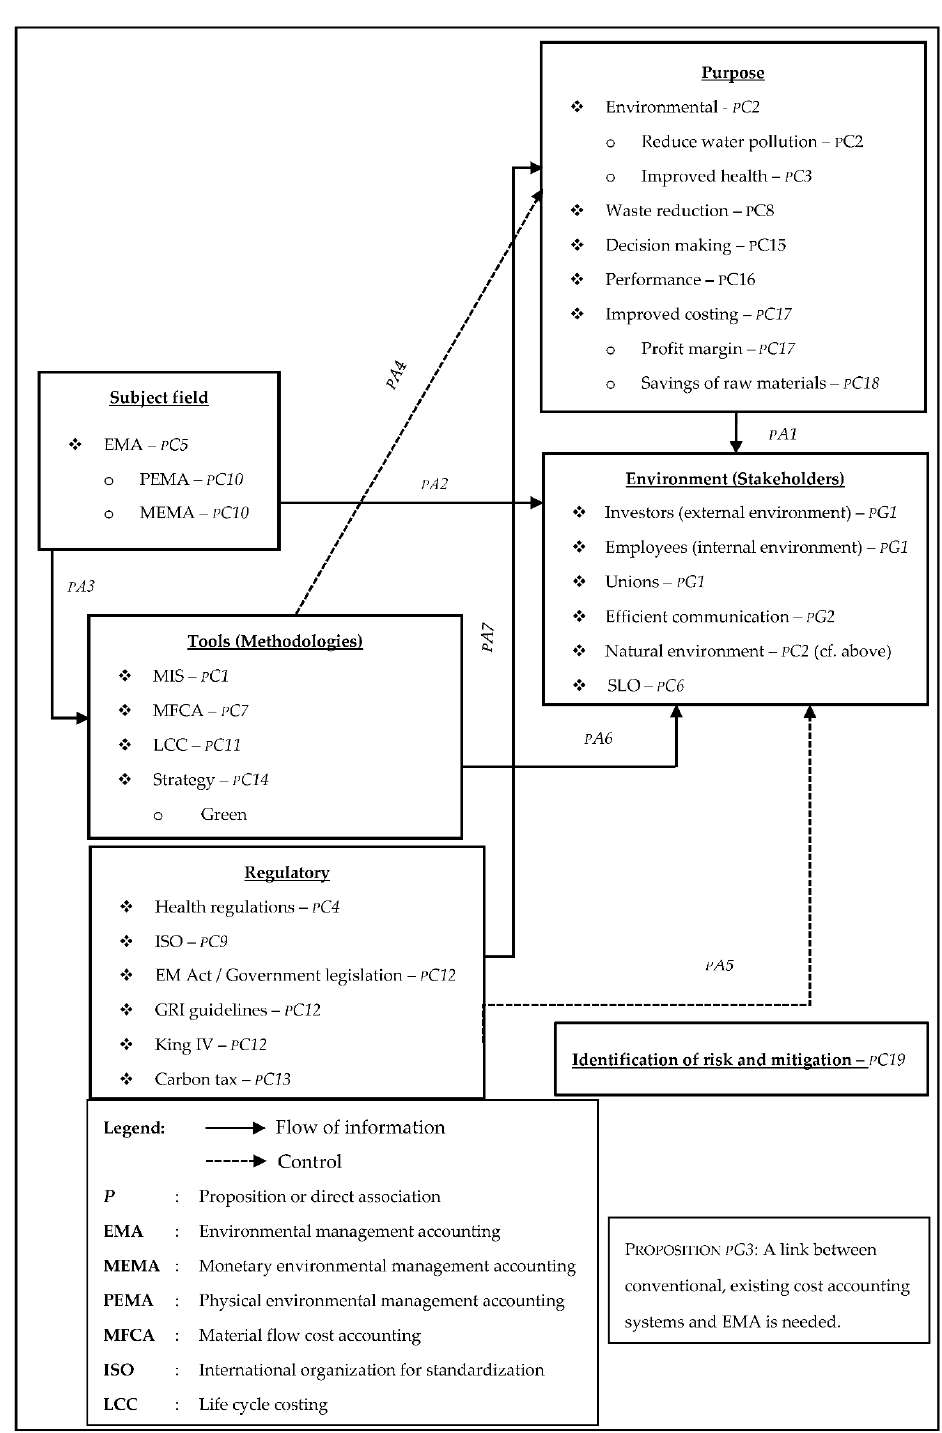
Figure 1. Conceptual framework embedding three sets of propositions.